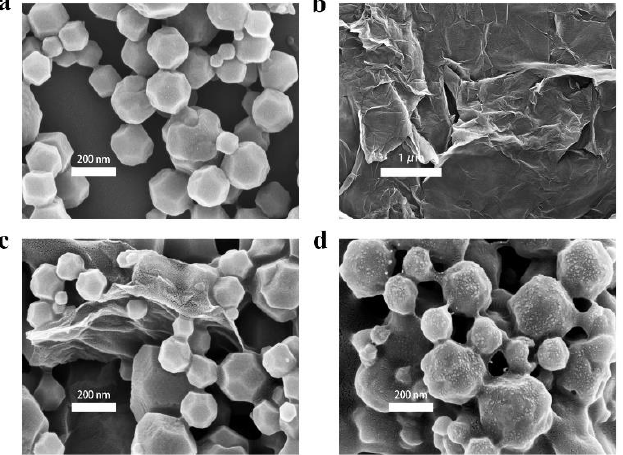
Figure 1. SEM image of ( a ) ZIF-8, ( b ) GR, ( c ) ZIF-8/GR, and ( d ) ZIF-8/GR/AChE-CS.